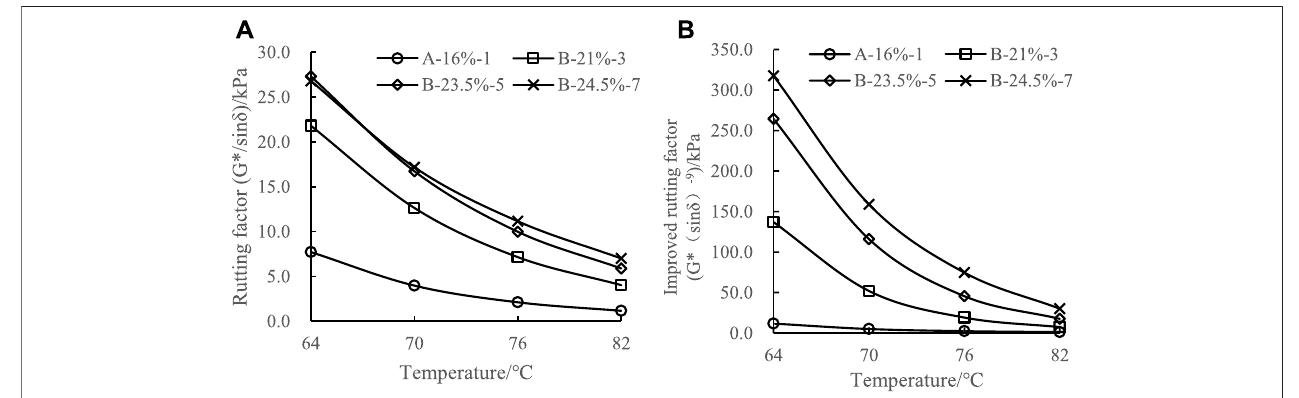
FIGURE 4 | The trend of two rutting factors of different modi fi ed asphalt. (A) Conventional rutting factor (B) Improved rutting factor.